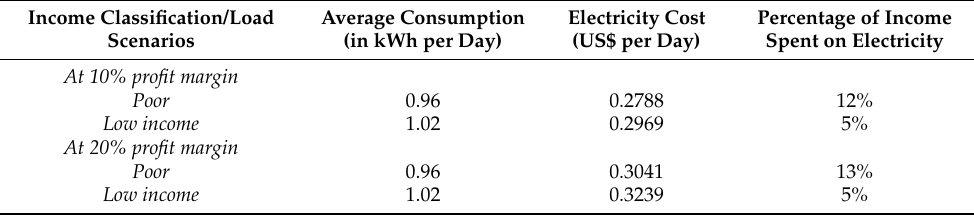
Table 9. Capacity to pay per household per income classification